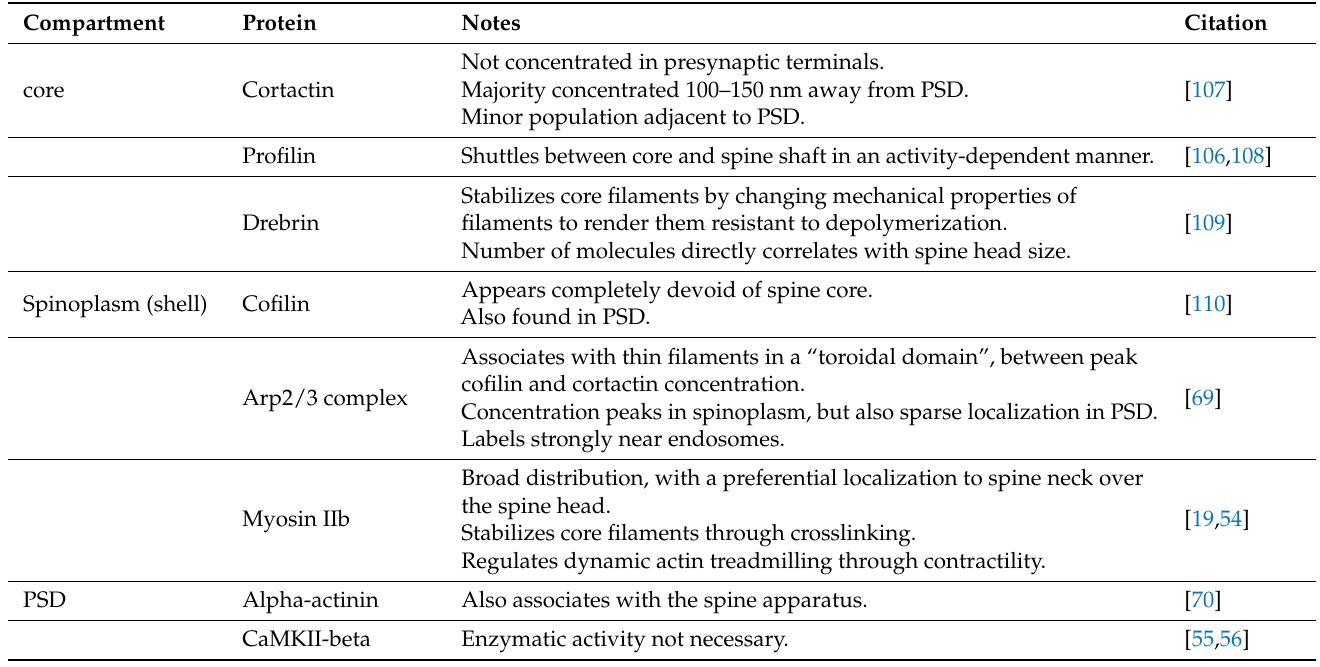
Table 3. Compartmentalization of actin regulators in dendritic